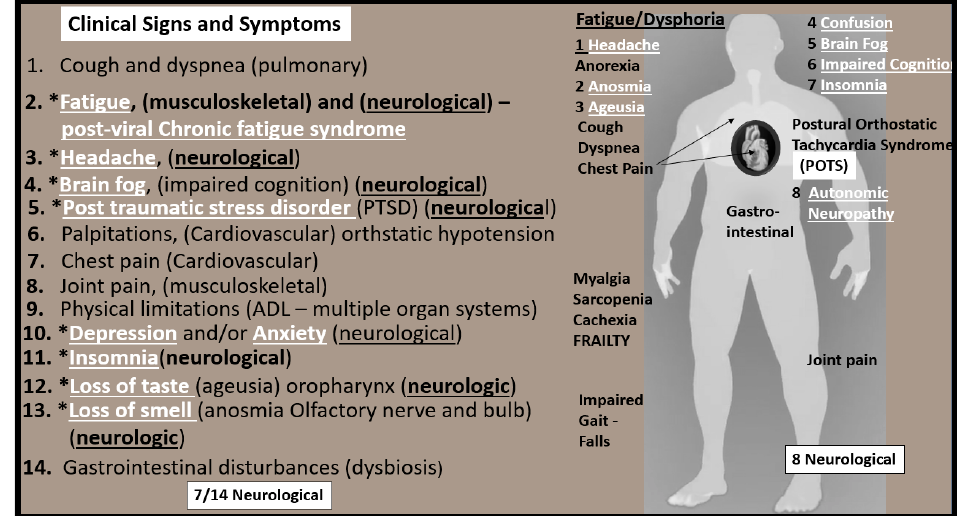
Figure 10. Clinical Signs and Symptoms of LC/PASC. This illustration shares at least 14 of the most common symptoms reported by LC/PASC individuals. Note that the symptoms that are related to neurological manifestations are underlined and appear in white bold font and preceded by asterisks. Additionally, note that fatigue and dysphoria are at the top of the list at the heading of the ‘standing man’ to the right-hand side of this figure as one of most aggravating clinical signs and symptoms of the remaining neurological manifestations. Further, note that this ‘standing man’ is portrayed as being a muscular robust individual that is not frail or old. In many cases, the individuals who have LC/PASC are very healthy and even